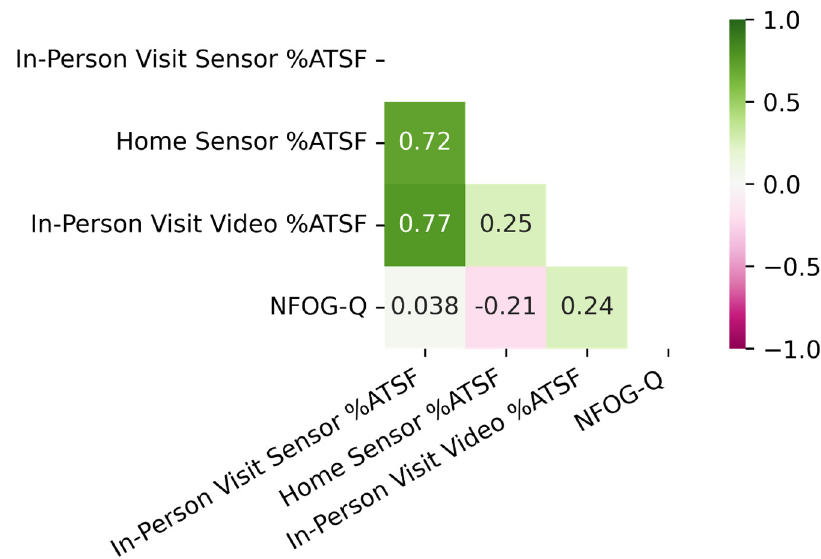
Figure 1. In-Person Visit Correlations. n = 19. Values represent Spearman’s Rho values. “In-Person Visit” refers to Clinic FOG Tasks + Simulated IADL tasks. “Sensor %ATSF” refers to sensor-based percent active time spent freezing, and “Video %ATSF” refers to video-based percent of active time spent freezing, as determined by an expert rater upon video review.